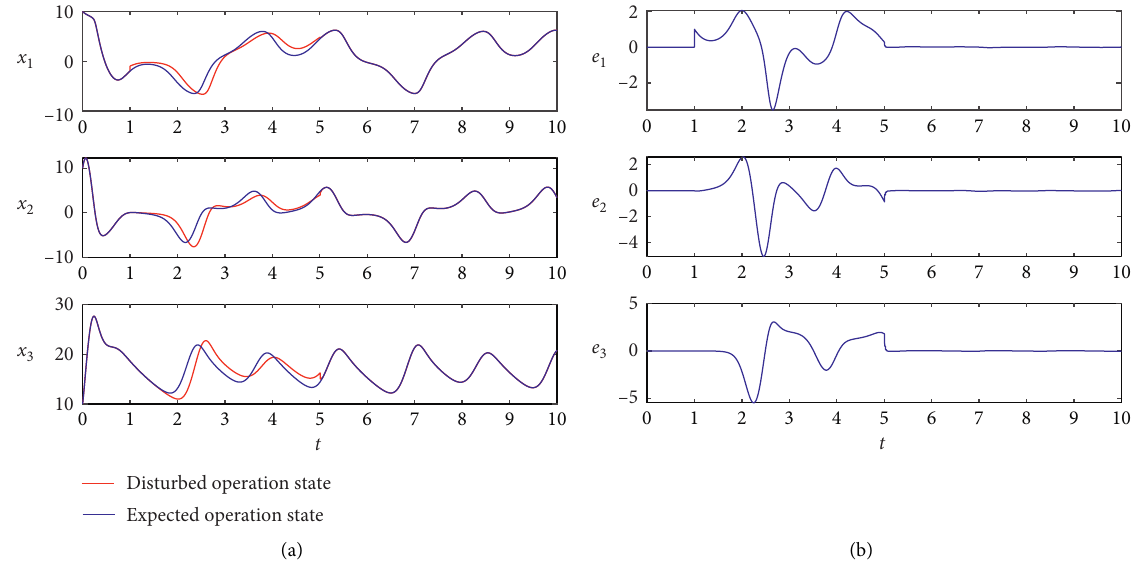
Figure 5: Impulsive synchronization of supply chain system (3). (a) Time series of x